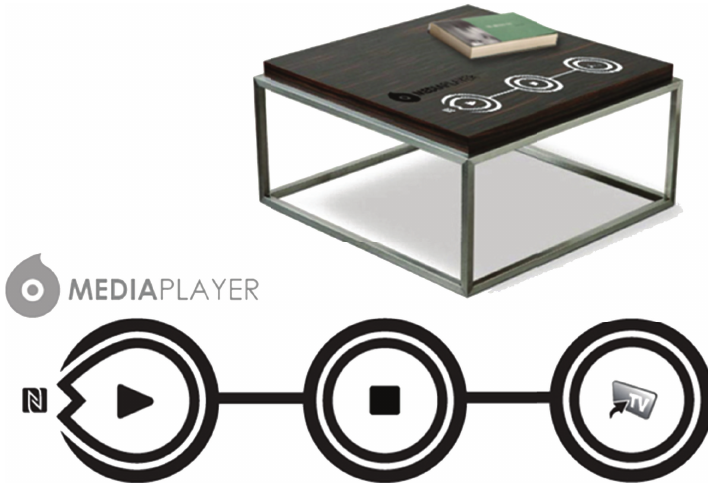
Figure 10: Controlling a media player.